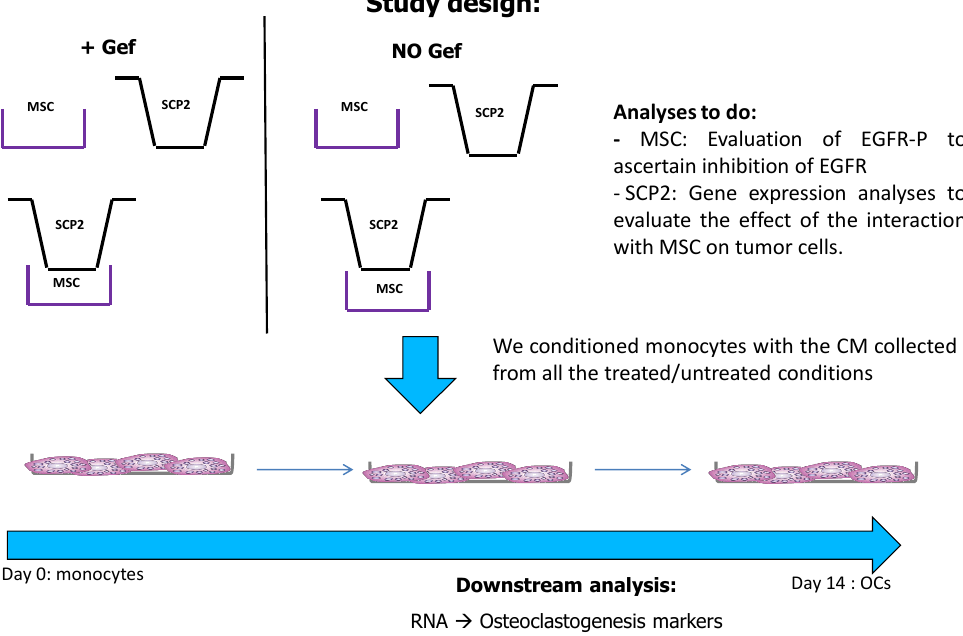
Figure 1. Experimental design: the preclinical model optimized in this paper includes a 2-phase cell culture; in the first phase cancer cells and Mesenchymal stem cells (MSC) were co-cultured sharing medium using transwell inserts. The media obtained from SCP2, MSC and the COCO were collected and used to condition the monocytes toward differentiation throughout the osteoclastogenic assay (CM changed every 2–3 days; assay total duration, 14 days). The conditioning of the monocyte with the CM derived from all the samples during the second phase of the experiment (indirect COCO).